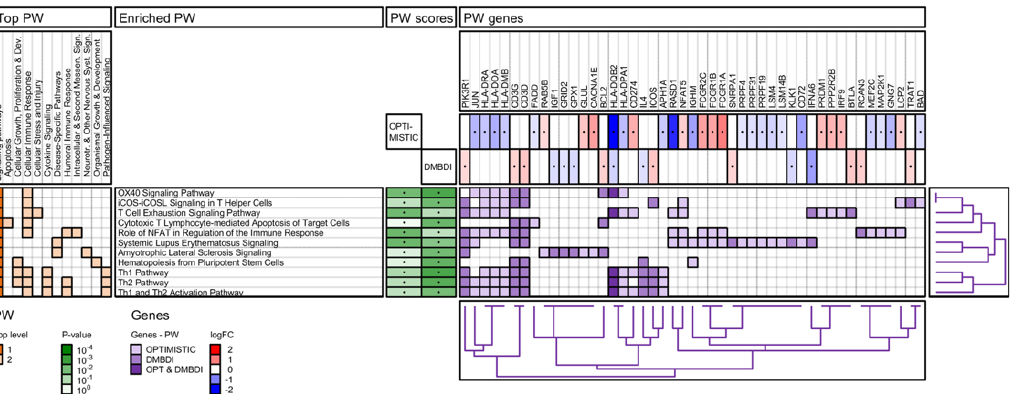
Figure 3. IPA pathway (PW) enrichment analysis of OPTIMISTIC and DMBDI genes. For explanation see Section 2.4.